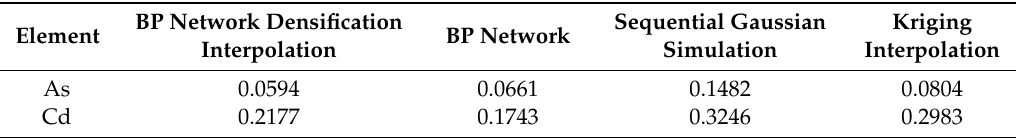
Table 4. Comparison of the mean square errors of the results by each estimation method.